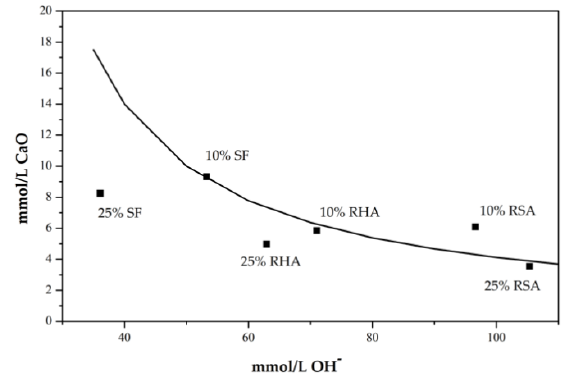
Figure 8. Comparison results of Frattini test for RSA, rice husk ash (RHA) and SF at 10% and 25% after 8 days.